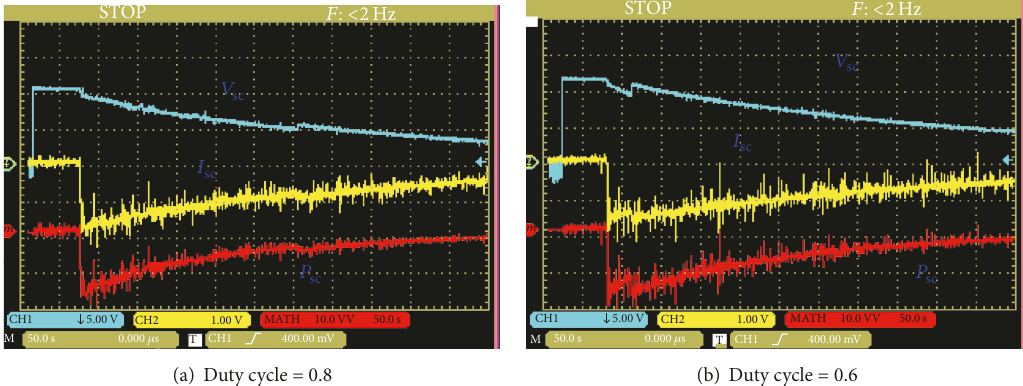
Figure 15: Voltage, current, and power waveforms of the ultracapacitors (discharging mode: parallel).